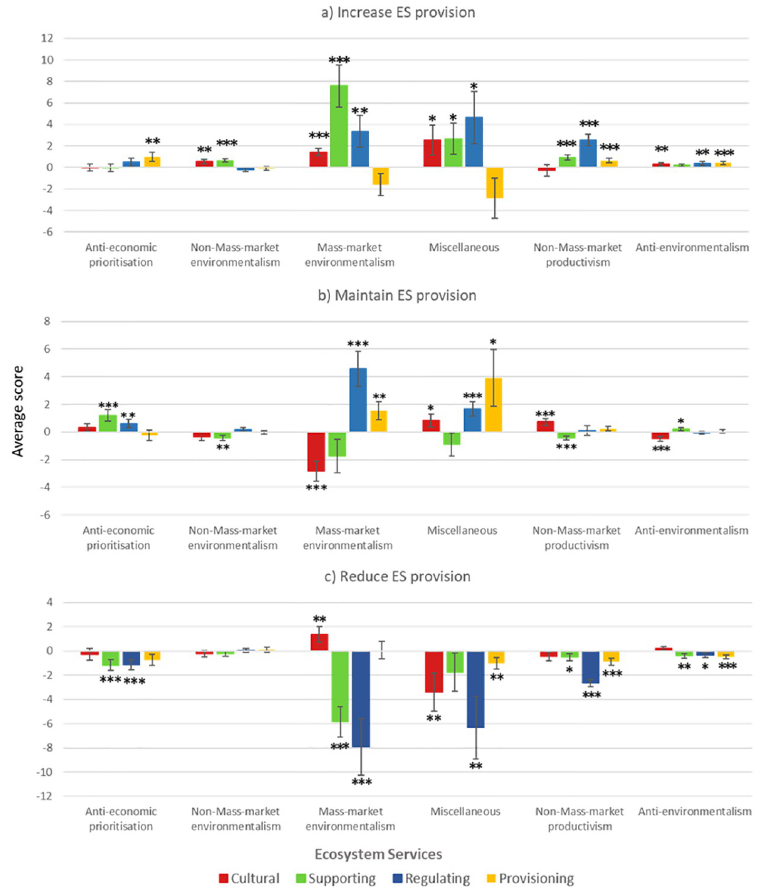
Fig 3. Respondents’ ES valuation for the different latent social groups in the different scenarios. Fig 3a–3c, represent how different social groups valued ES attributes in various scenarios. A more detailed description of scenarios is provided in [24, 25]. Black stars refer to trends (90%, 1 star) and significant scores (95% and 99% for 2 and 3 stars, respectively). Deviation bars denote standard error. For more detailed statistical results, see A2 Table in S1